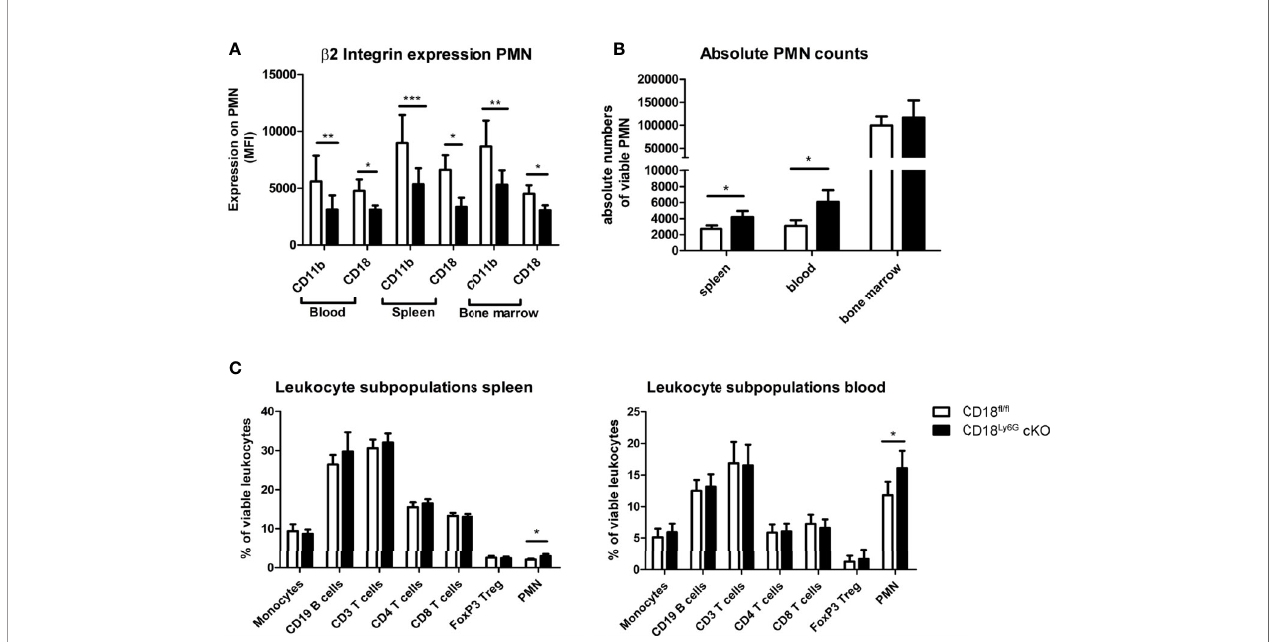
FIGURE 1 | Phenotypical and functional characteristics of CD18 Ly6G cKO mice compared to CD18 fl / fl mice. We found a signi fi cant reduction of b 2-integrin surface marker expression (CD11b, CD18) on PMN derived from blood, spleen, and bone marrow (A) . Data depict the results of in-vitro experiments from n=7-17 mice/ genotype. In the same set of experiments we further observed higher absolute and relative counts of PMN in CD18 Ly6G cKO mice as compared to CD18 fl / fl mice (B,C) , whereas the proportions of other leukocyte subpopulations did not differ signi fi cantly (C) (n=10/genotype). Legend in (C) applies to all panels. Statistically signi fi cant differences between groups are indicated (*p<0.05, **p<0.005, ***p<0.001).